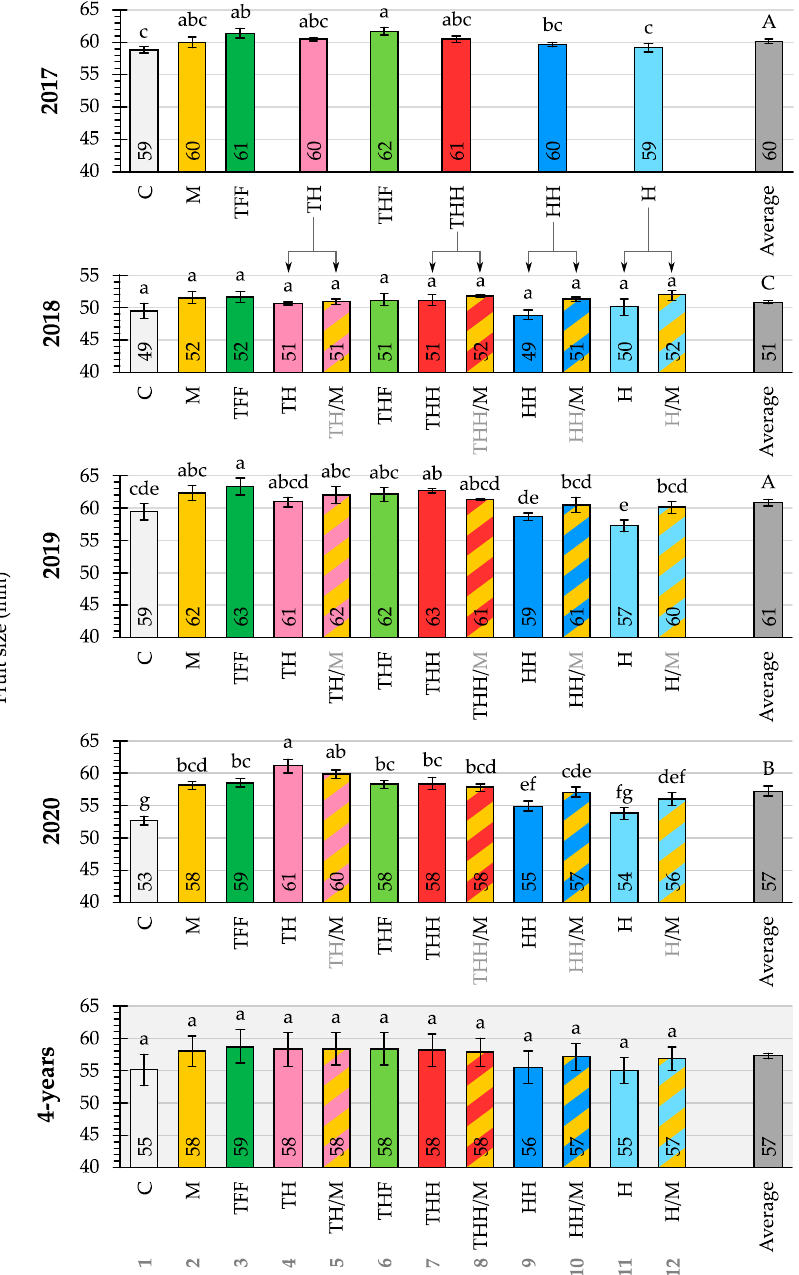
Figure 5. Fruit size (equatorial diameter, mm) (average value—indicated numerically within the column—with standard error bar) by pruning strategy (1–12) and the average for all strategies, for each year and for the four years overall. Different lowercase letters above the bars for each year and four-year overall indicate significant differences (LSD test, p < 0.05). Different capital letters above the bars of the averages of all strategies for each year indicate significant differences (LSD test, p < 0.05).